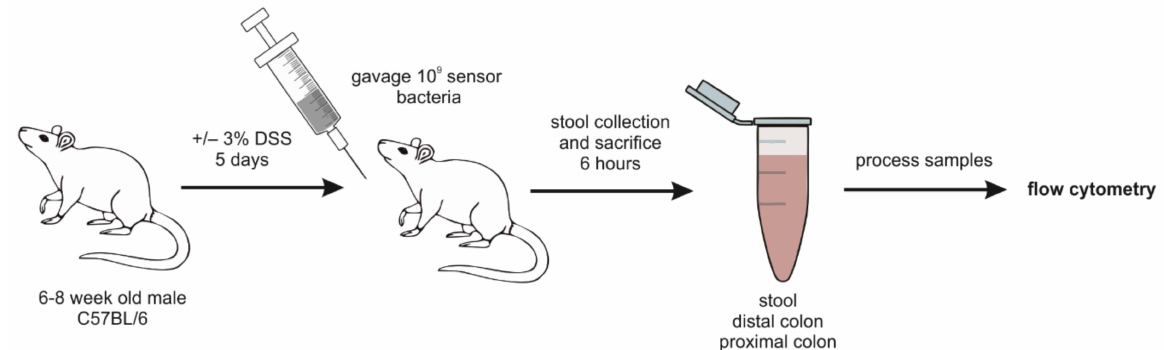
Figure 5. In vivo measurement of thiosulfate and tetrathionate in healthy and inflamed mice. Experimental design. 6- to 8-week-old C57BL/6 mice were given water with or without 3% DSS for 5 days before oral gavage with sensor bacteria. After 6 h, samples were collected from the mice, processed, and analyzed by flow cytometry to measure GFP